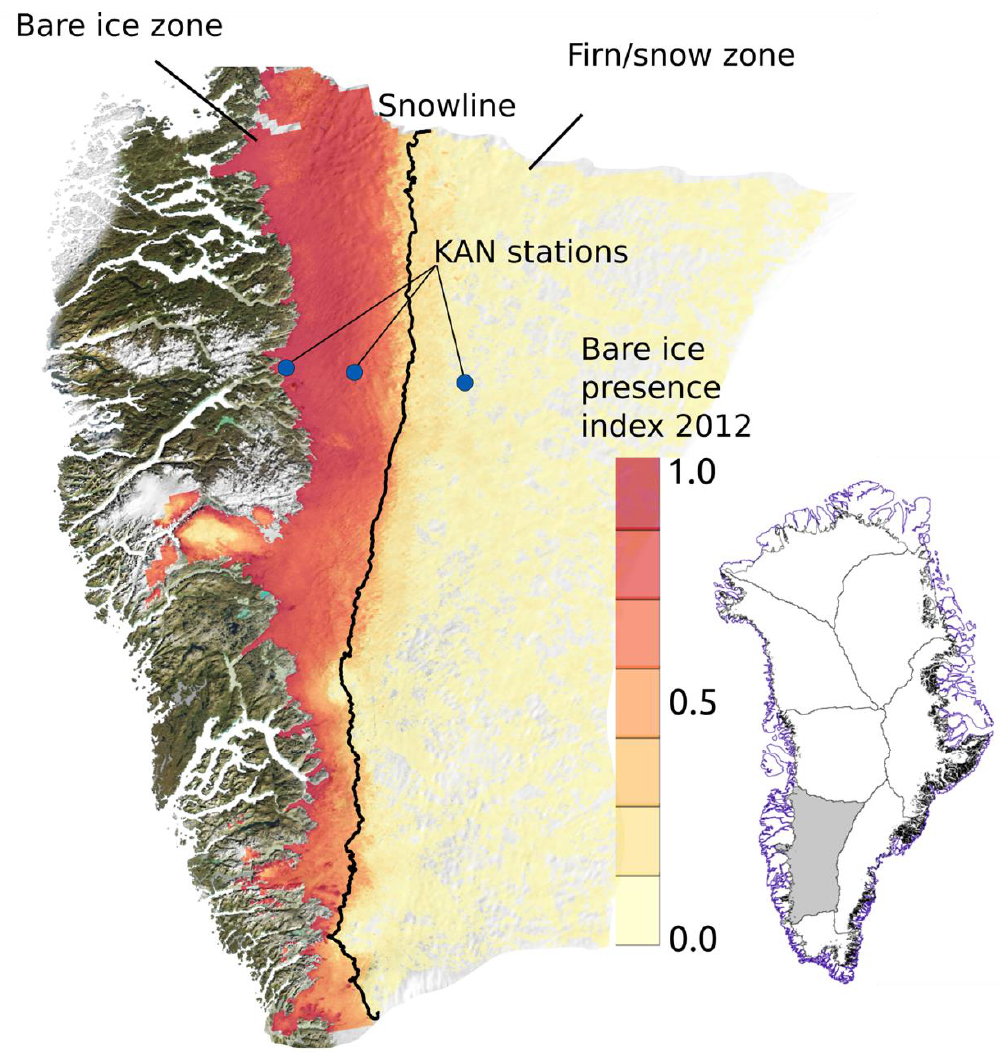
Figure 9. The average end-of-summer (maximum) snowline position for the southwest sector of the Greenland Ice Sheet during the period 2001–2017 as determined from MODIS MOD09GA surface reflectance, reprinted with permission from Ryan et al. [26] (courtesy Johnathan Ryan, Brown University). Daily reflectance maps for June, July, and August were classified into bare ice, snow-covered, and water-covered pixels using supervised random forest classification. The bare ice presence index is an exposure frequency representing the fraction of total days classified as bare ice for each pixel. The average end-of-summer snowline elevation is 1520 ± 113 m in this sector, with interannual variation of ± 385 m. Interannual snowline variability explains 53% of MOD10A albedo variability [26].